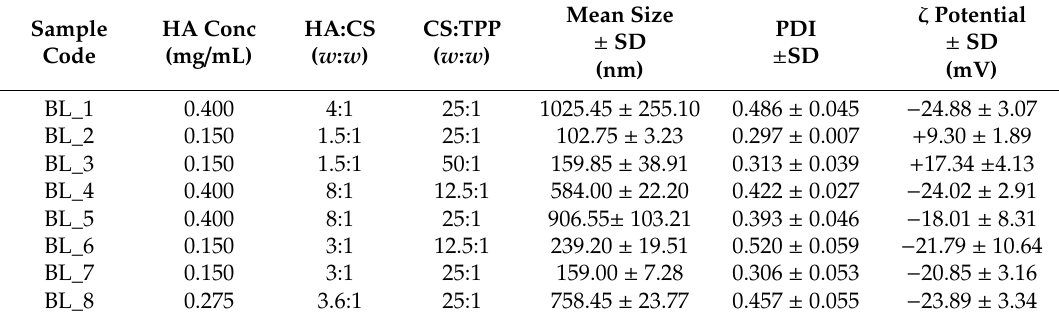
Table 1. Set-up of placebo hyaluronic acid (HA) / chitosan (CS) nanoparticles (NPs) on-chip